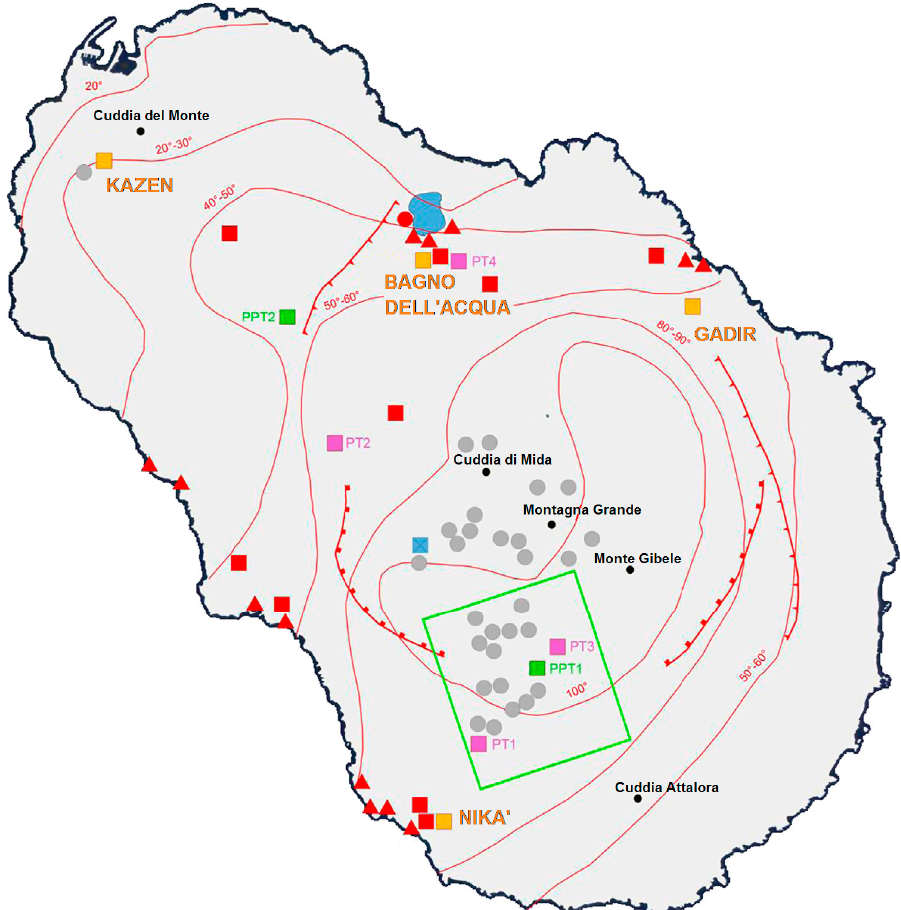
Figure 14. Exploration pits for geothermal source.